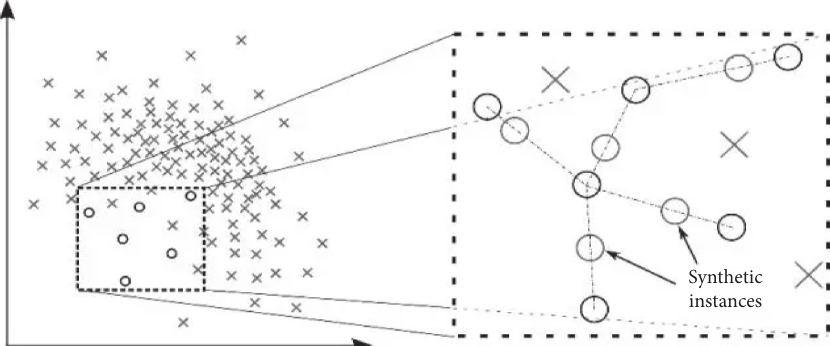
Figure 2: Schematic diagram of the synthetic instances by the SMOTE algorithm [14].